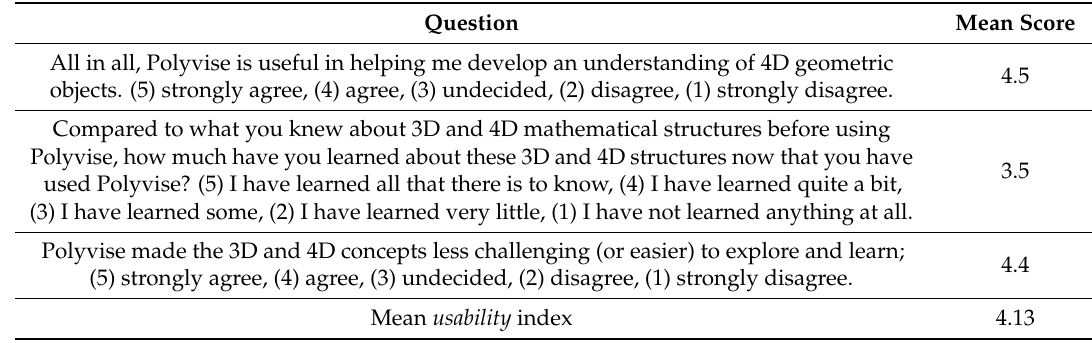
Table 1. Participants’ assessment of the overall usability of